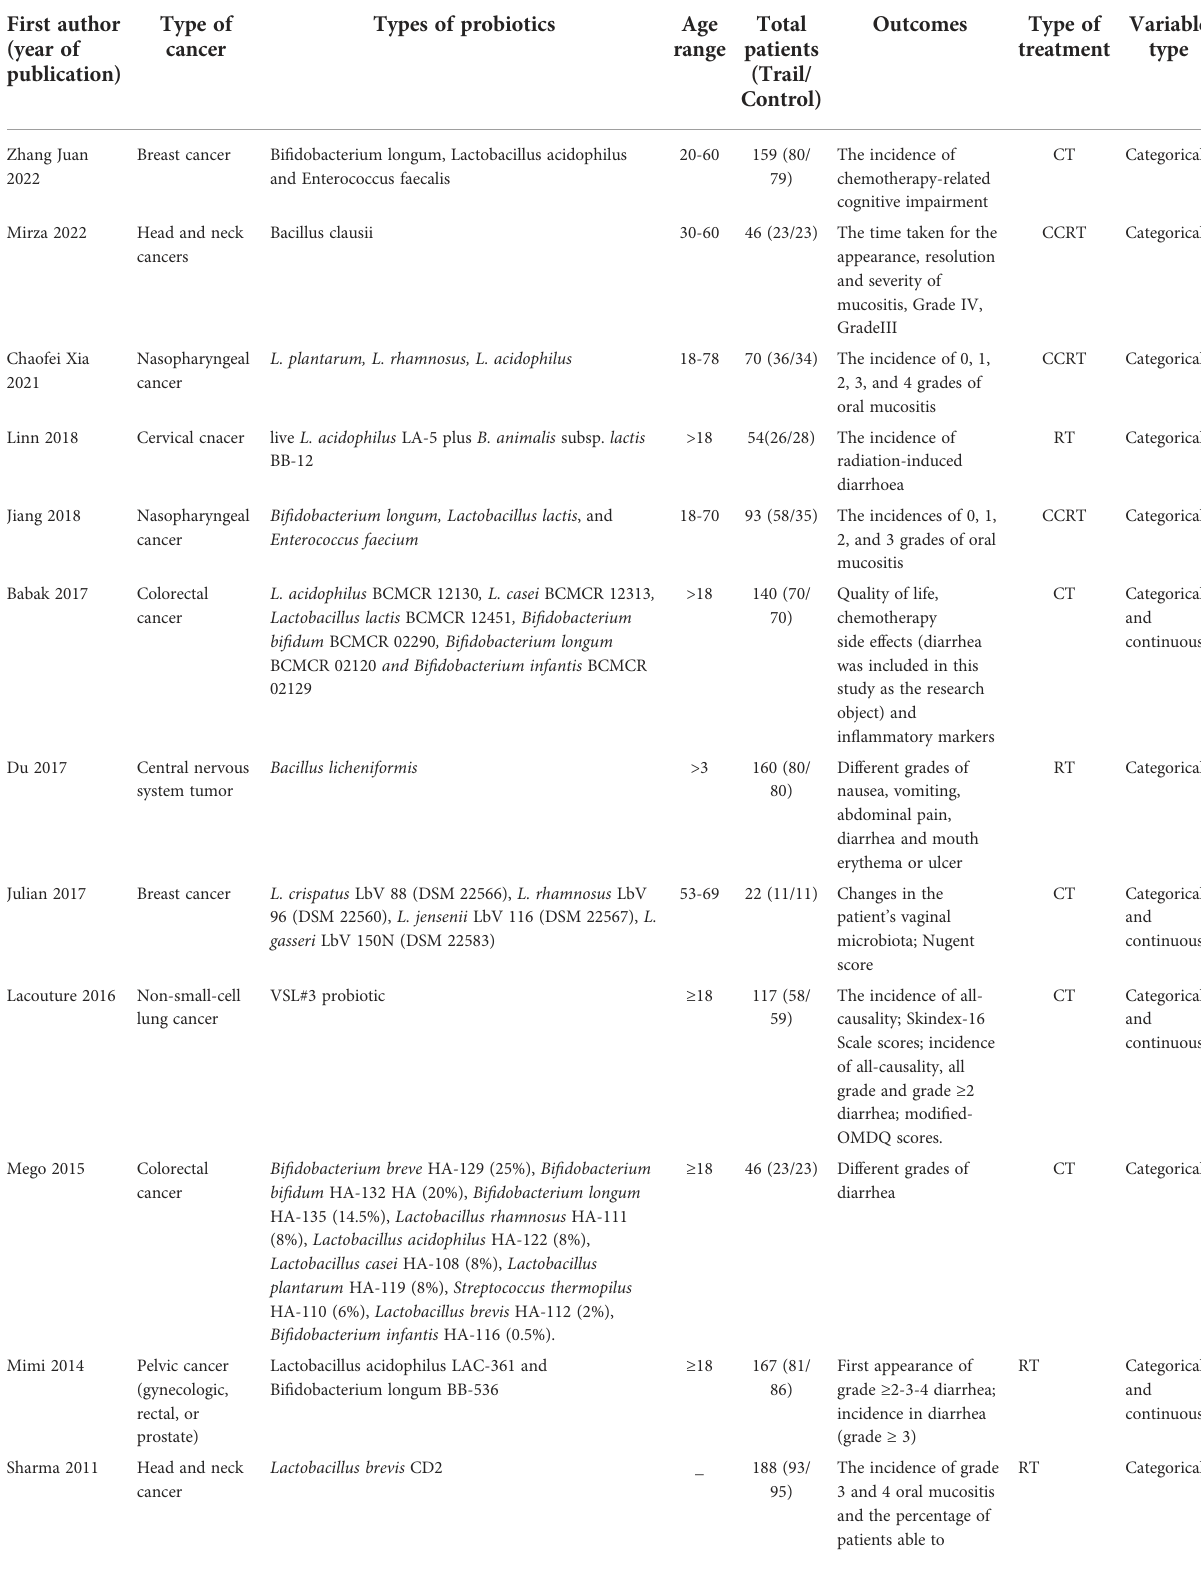
TABLE 1 Characteristics of the studies included in the